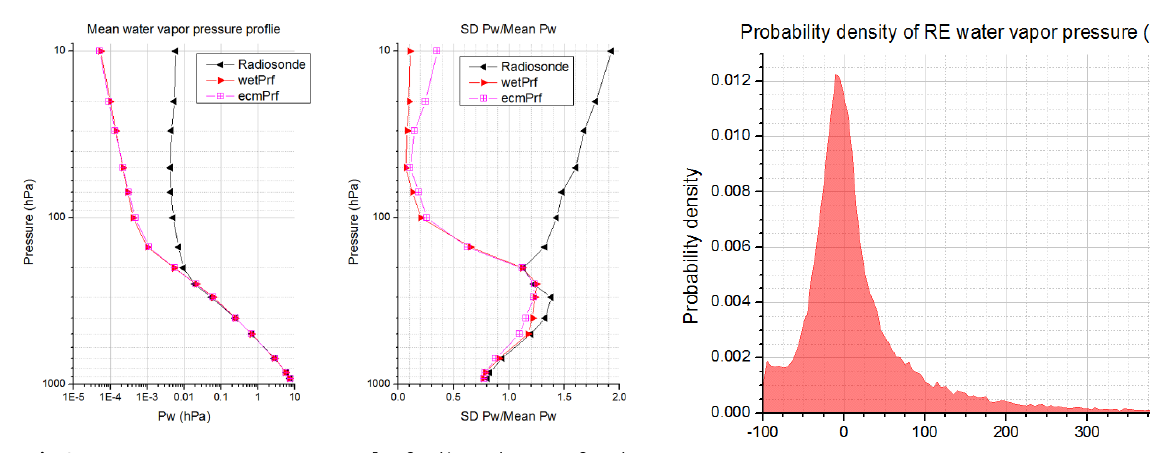
Fig. 3. Mean water vapor pressure profile of radiosonde, wetPrf, and the background ecmPrf.